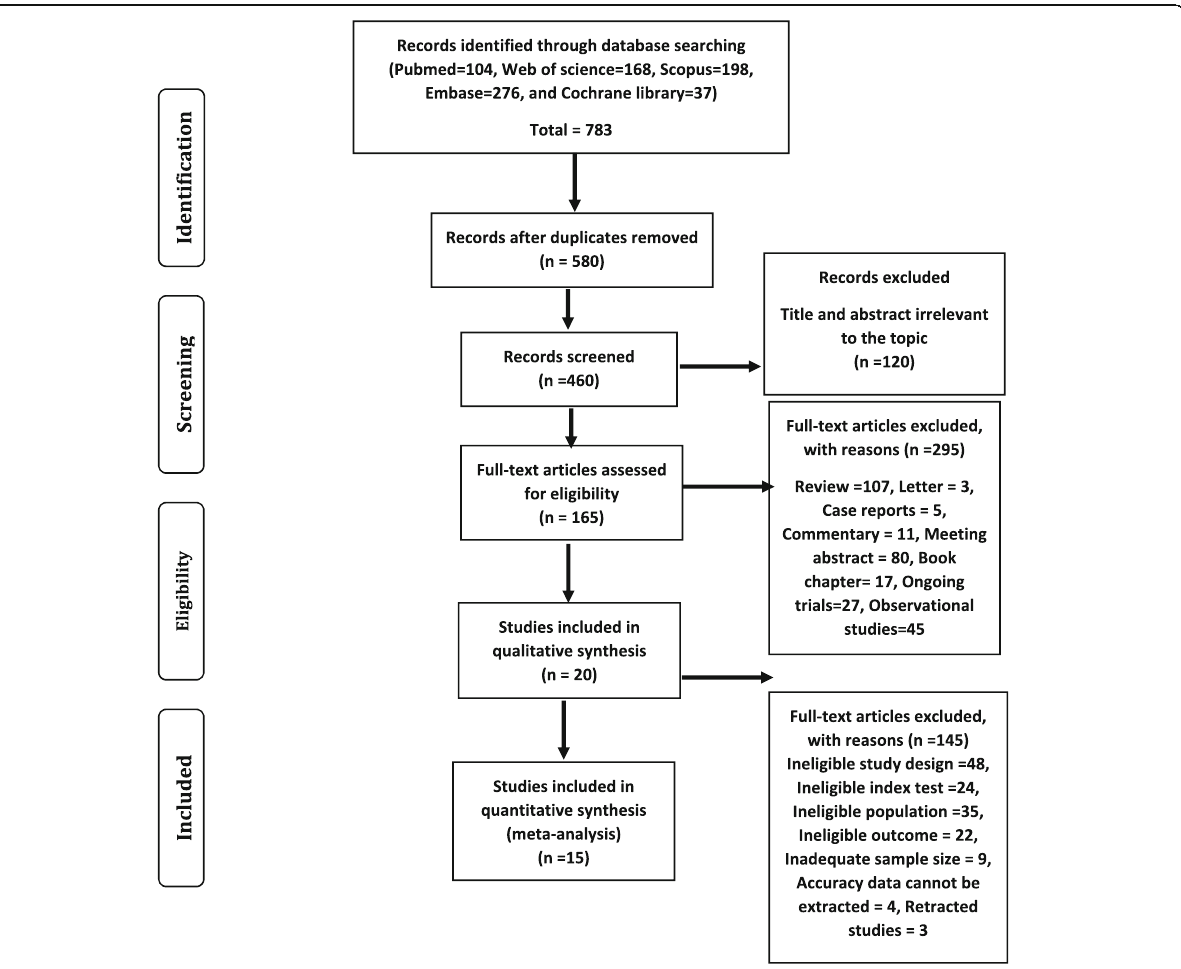
Fig. 1 Flow diagram of the study selection